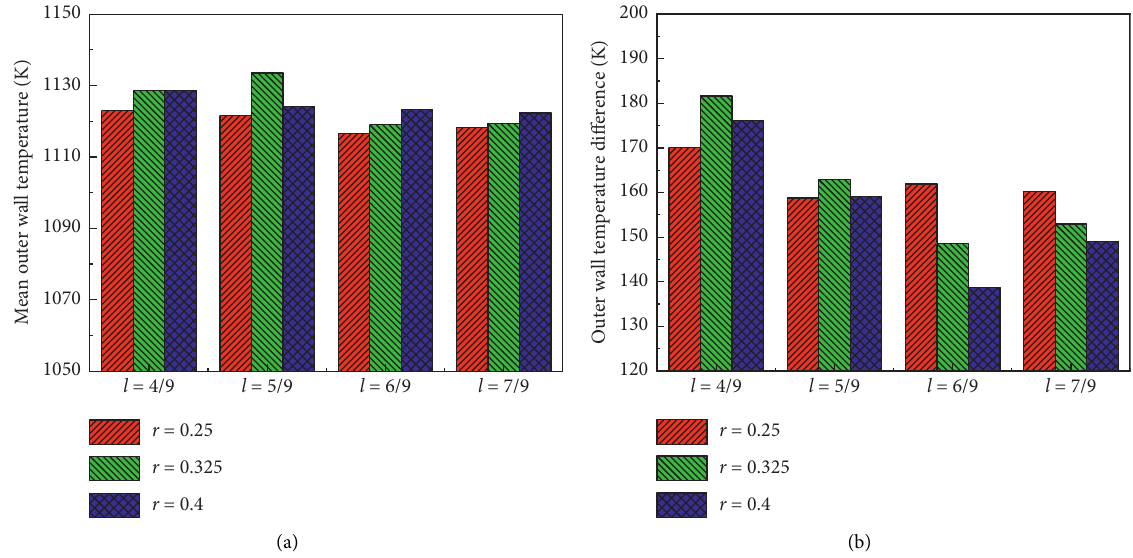
Figure 8: Mean outer wall temperature and outer wall temperature at various l and r .